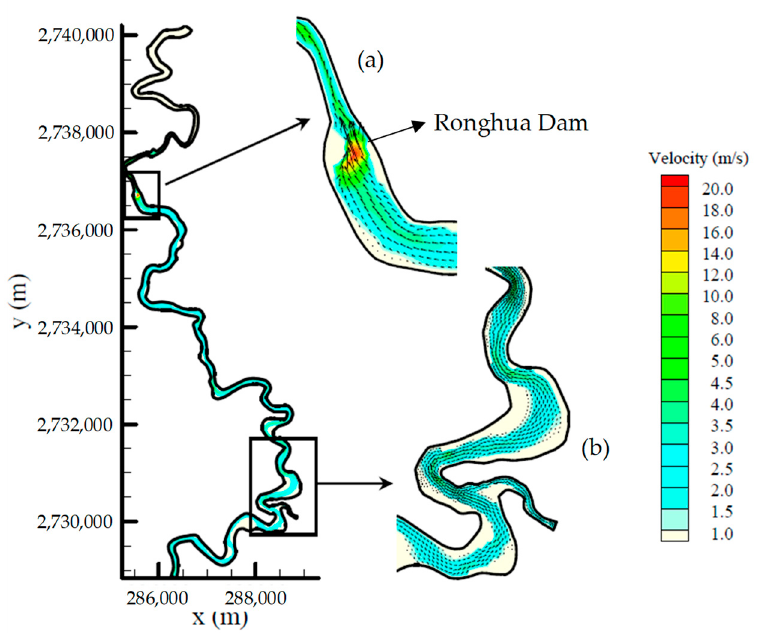
Figure 5. Flow field and contours of flow velocity at 10 am on August 8, 2009 (during the Typhoon Morakot event).